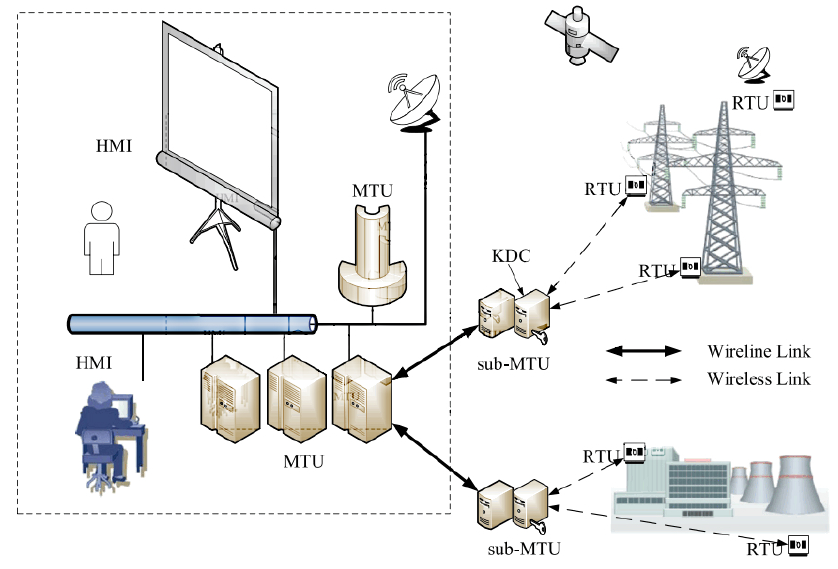
Figure 8. A simple supervisory control and data acquisition system